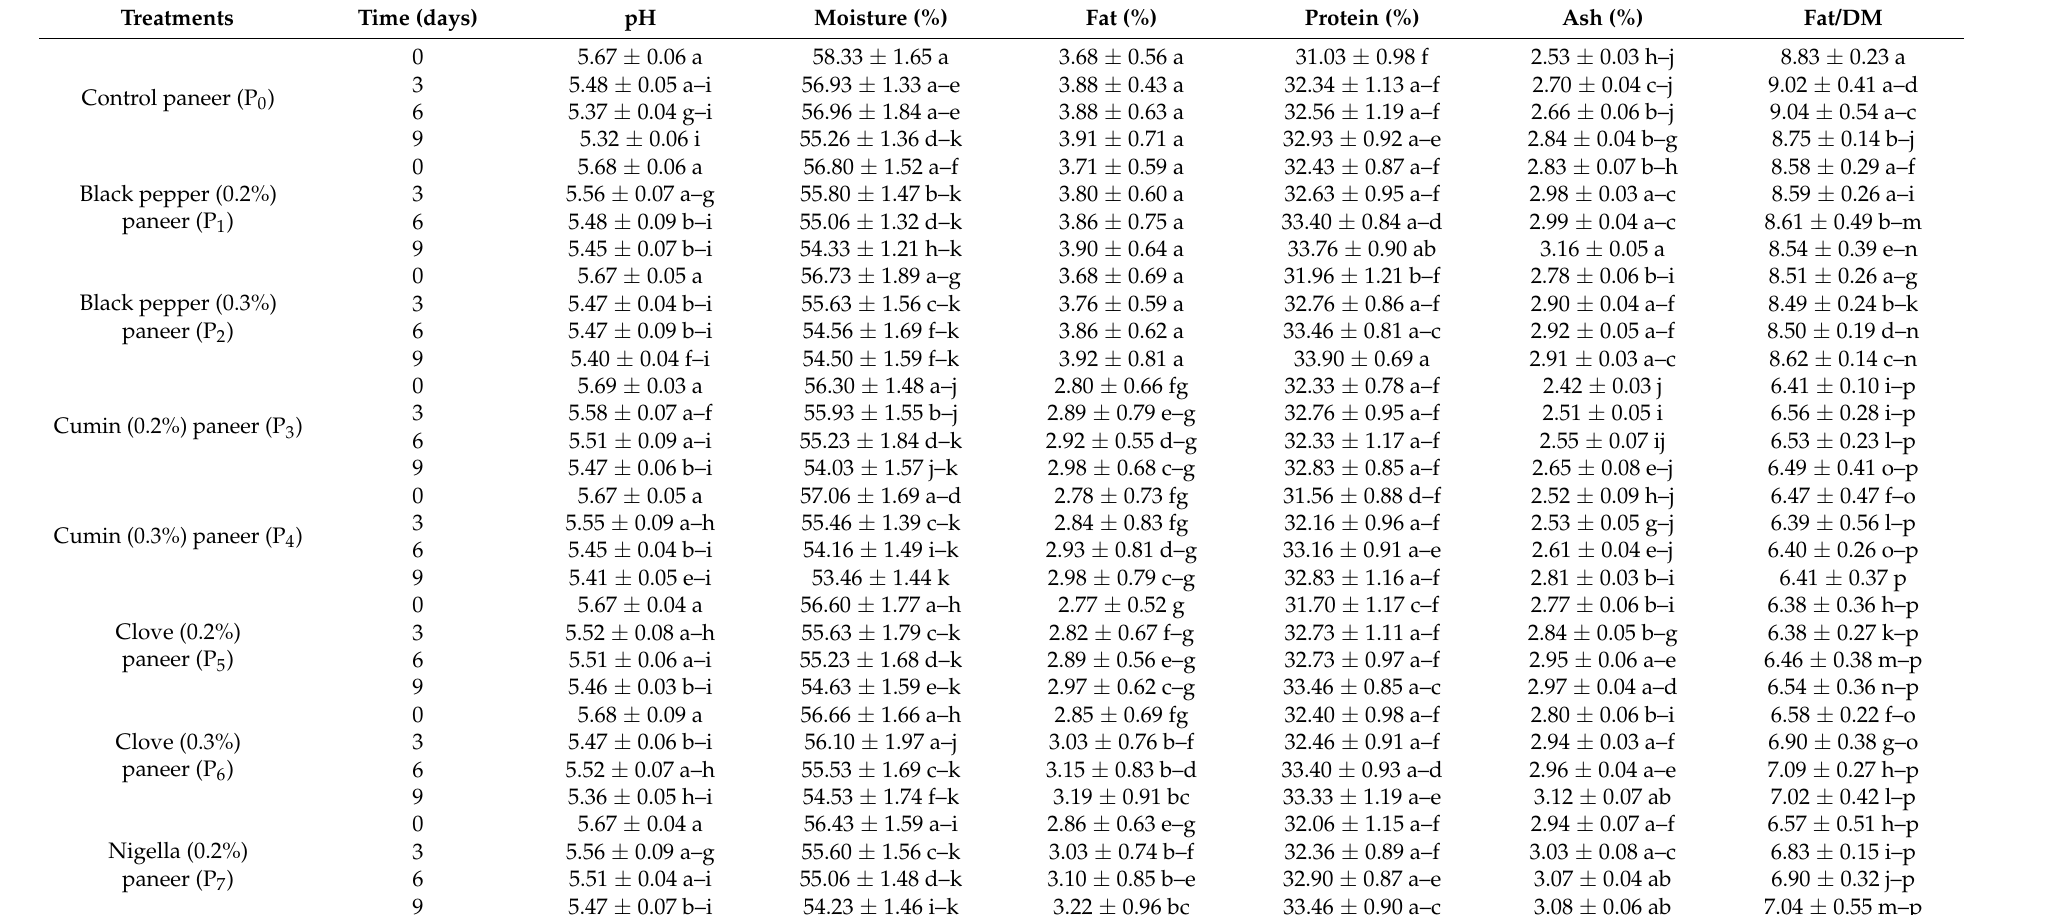
Table 2. Proximal characteristics (means ± SD) of paneer supplemented with different spices during